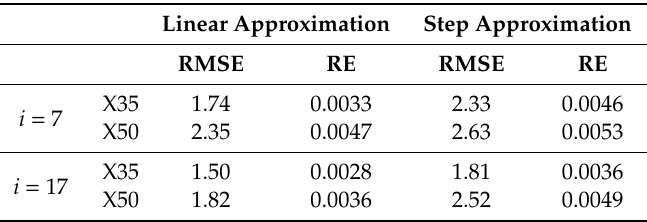
Table 1. Root-Mean-Square Error (RMSE) and Relative-Error (RE) between observed and calculated data with Piecewise-Linear (Columns 3 and 4) and Piecewise-Constant Step (Columns 5 and 6). Linear Approximation Step Approximation RMSE RE RMSE RE X35 1.74 i = 7